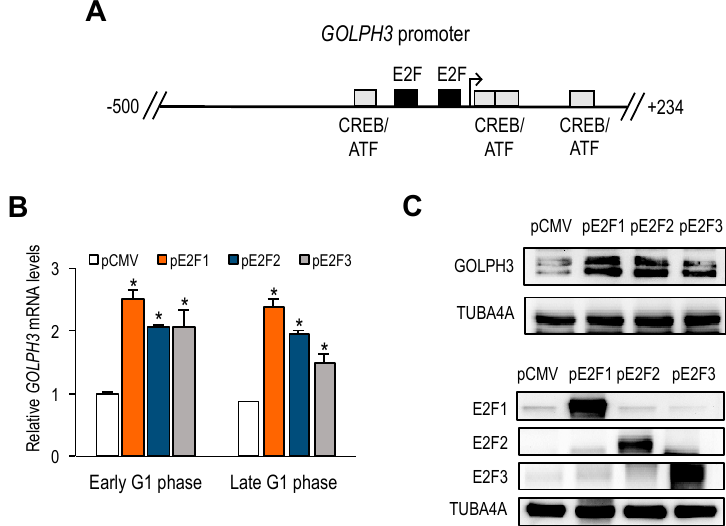
Figure 2. Identification of GOLPH3 regulatory sequences. ( A ) Schematic representation of transcription factor-binding sites in human GOLPH3 regulatory region ( − 500 to +234). E2F and ATF/CREB motifs are indicated as boxes. The transcriptional start site is depicted with an arrow. ( B ) RT-qPCR analysis of GOLPH3 mRNA expression in U2OS cells transfected with plasmids encoding E2F1, E2F2 or E2F3 proteins under CMV promoter, synchronized with Thy-Noc and subsequently released into the cell cycle. Expression values were normalized to the expression of EIF2C2 , used as standard control. Data are represented as fold-change (mean ± SD) relative to values of cells transfected with empty pCMV vector. *, p < 0.05. ( C ) Western analysis of GOLPH3 protein levels in U2OS cells overexpressing E2F1-3. Bottom panel shows E2F1, E2F2 and E2F3 protein levels after transfection of each E2F expression plasmid. Shown are the results of one representative experiment of three independent